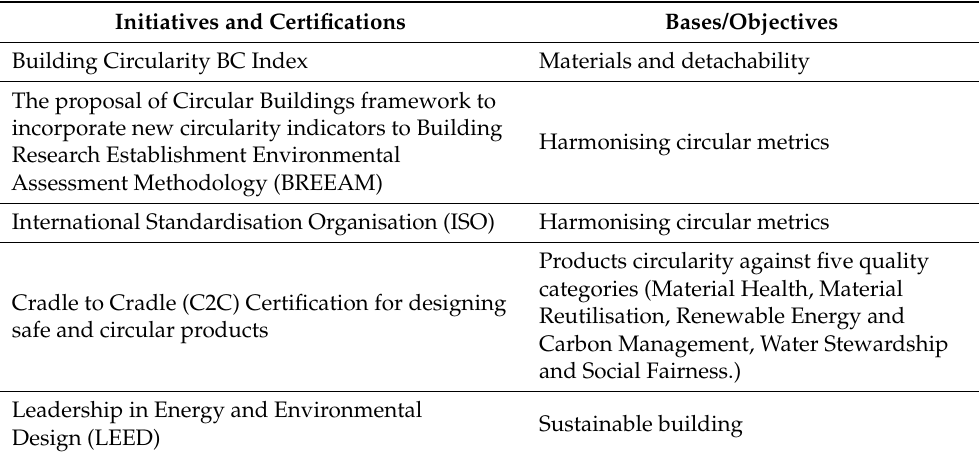
Table 4. Initiatives and certification in the field of Circularity and the Building sector. Initiatives and